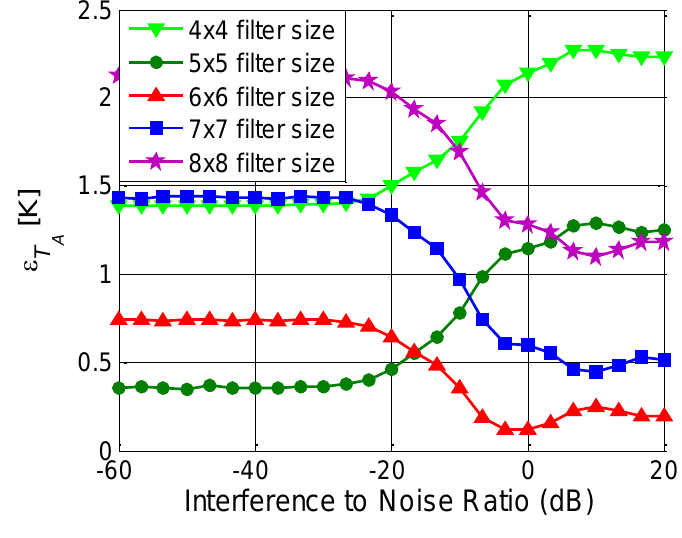
Figure 6. Error in the estimation of the antenna temperature as a function of the Interference-to-Noise Ratio